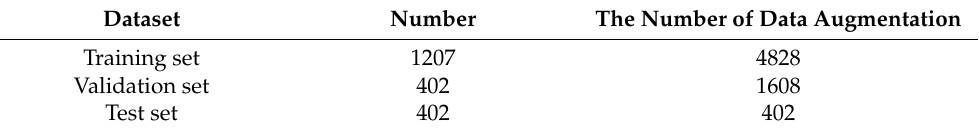
Figure 10. Statistics chart of dataset categories, ( a ) Statistics chart of categories at different spatial resolutions before data balance, ( b ) Statistics chart of categories at different spatial resolutions after data balance. Table 3. Overview after dividing the